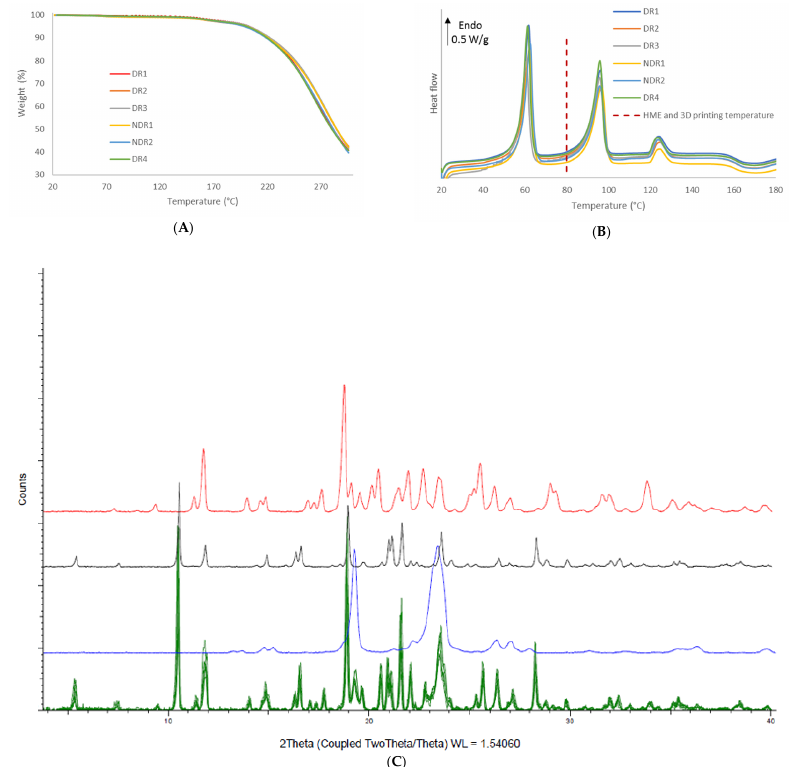
Figure 12. Thermal analysis and X-ray powder diffraction of PEO-based oral forms. ( A ) Thermal degradation profile, ( B ) DSC thermograms of the six oral forms batches and ( C ) X-ray powder diffraction spectra of the six oral forms batches ( green ), PEO ( blue ), amiodarone hydrochloride ( black ) and D -sorbitol ( red ).